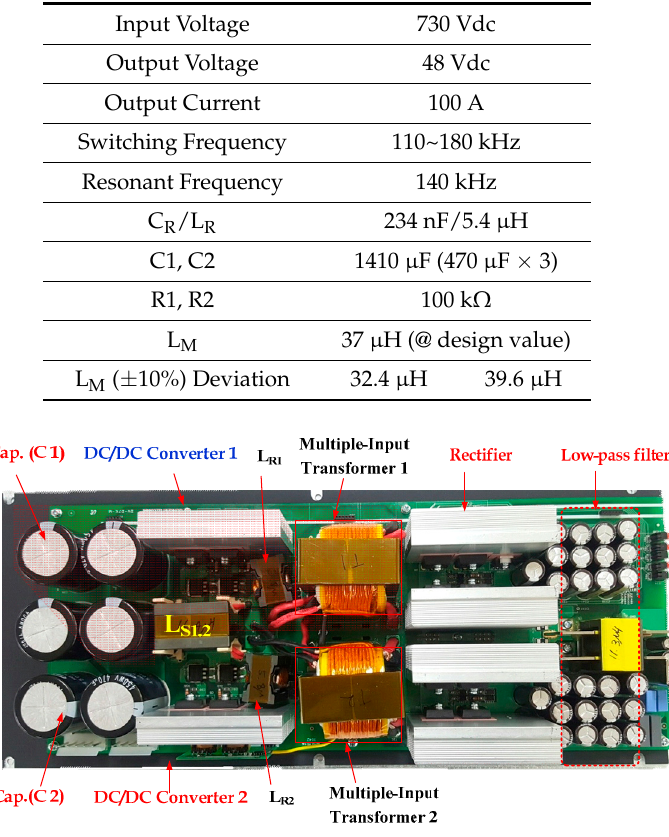
Table 3. Input balance characteristic of the proposed converter.